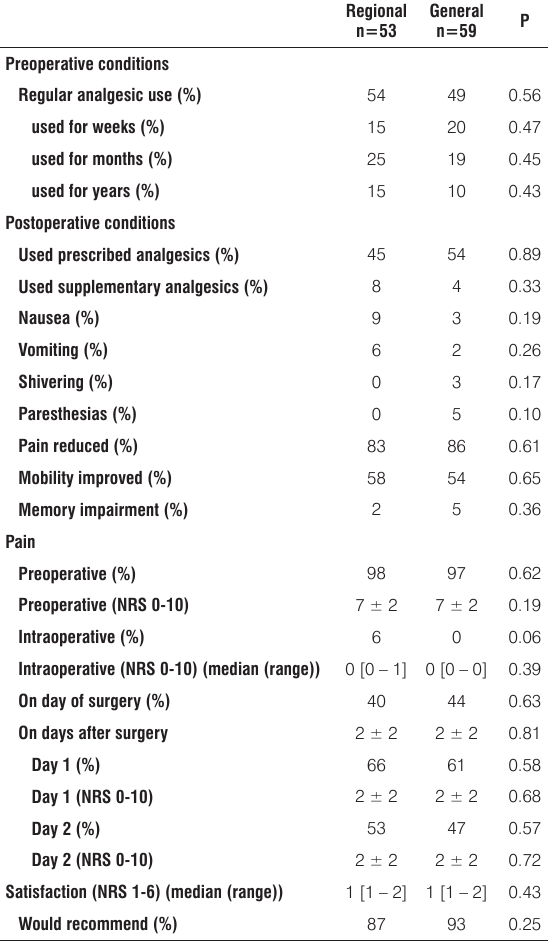
Table 5. Results of the